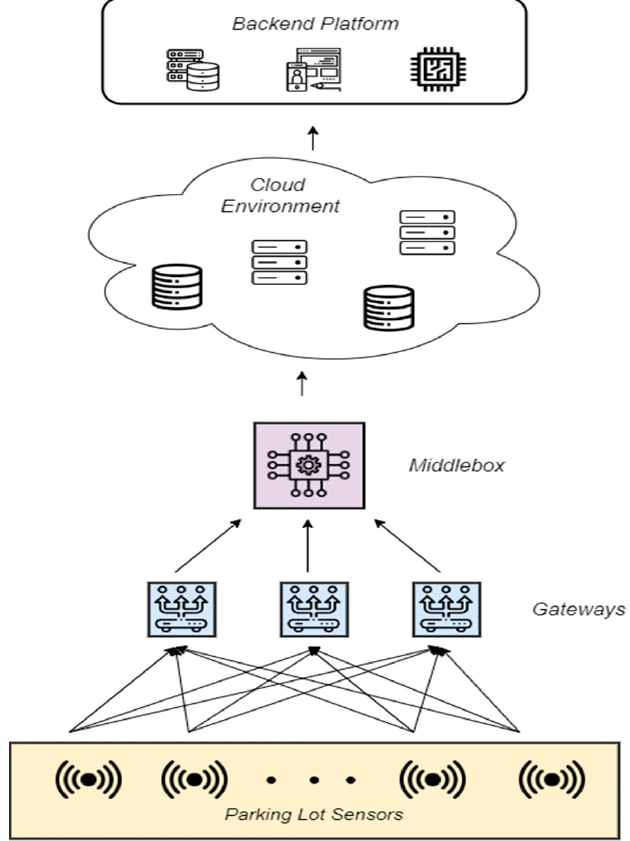
Figure 5. Architecture blueprint used by the network simulation.